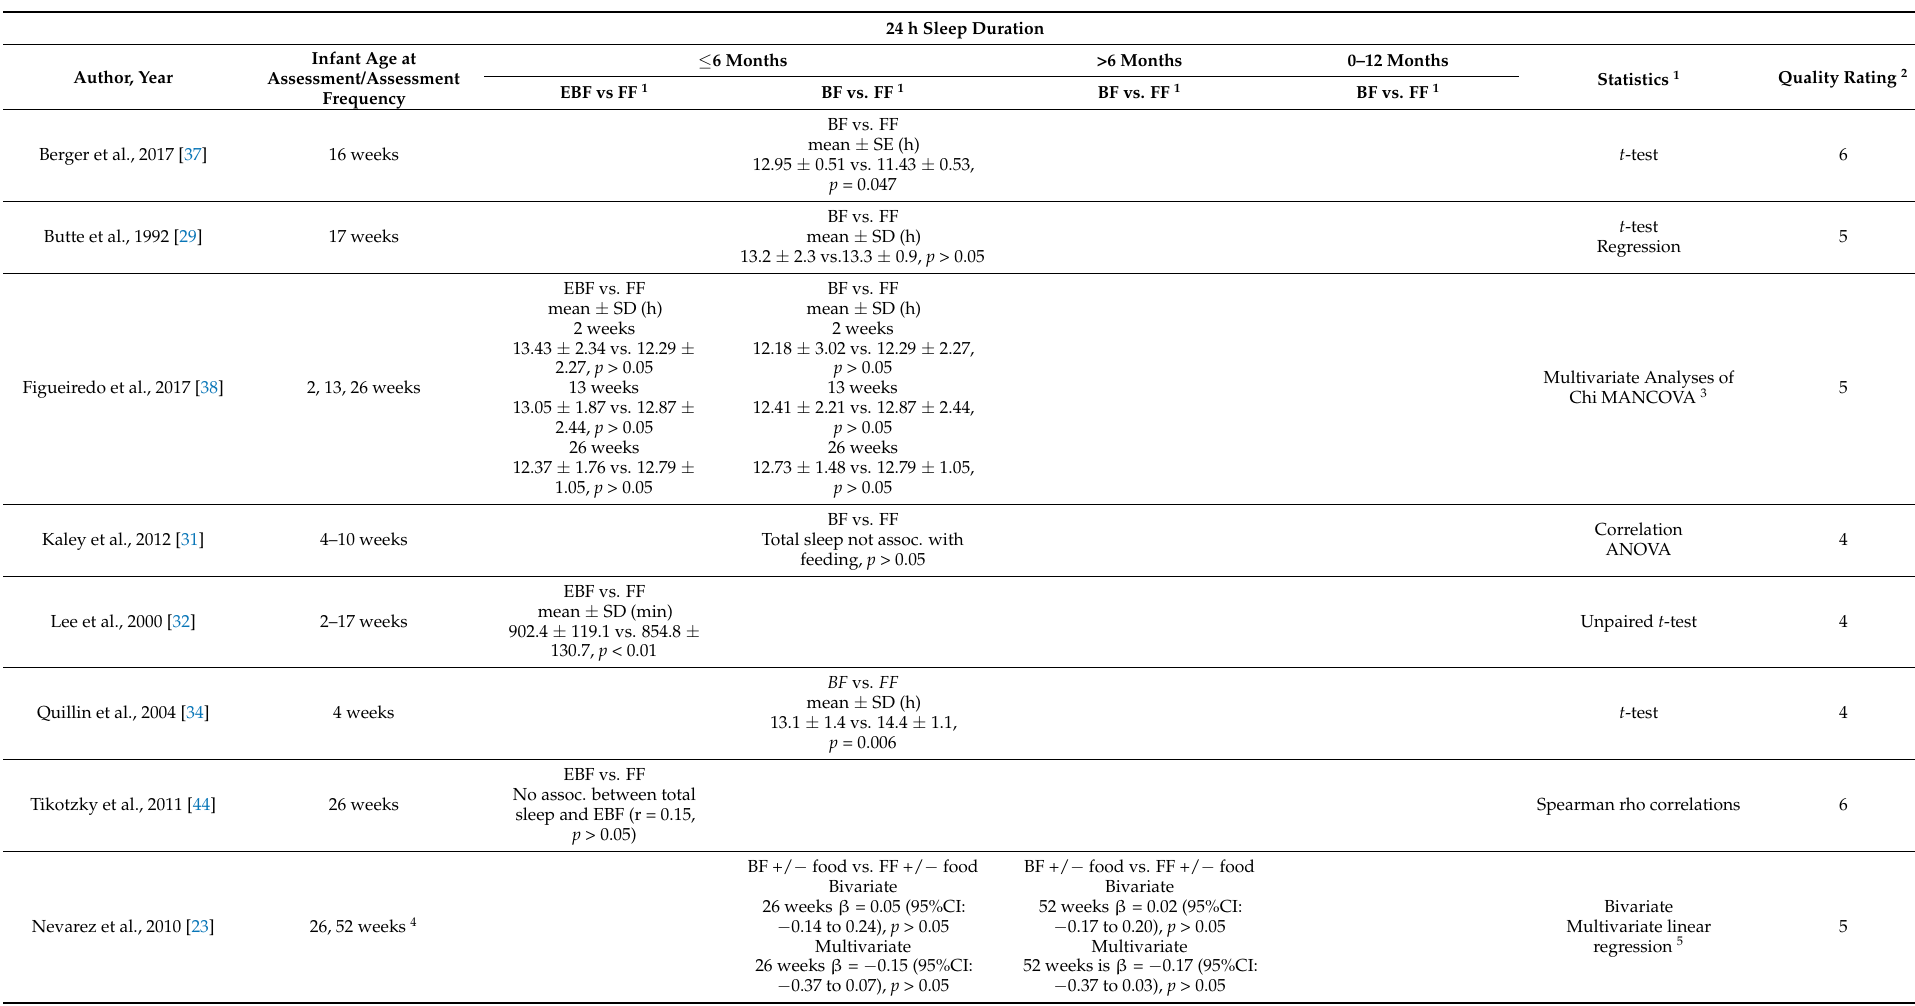
Table 2. Type of milk feeding among infants aged ≤ 6 months, >6 months, and 0–12 months in relation to sleep variables including 24 h sleep duration, total night-time sleep, night-waking frequency, duration of night wakings, longest sleep period, and sleep onset